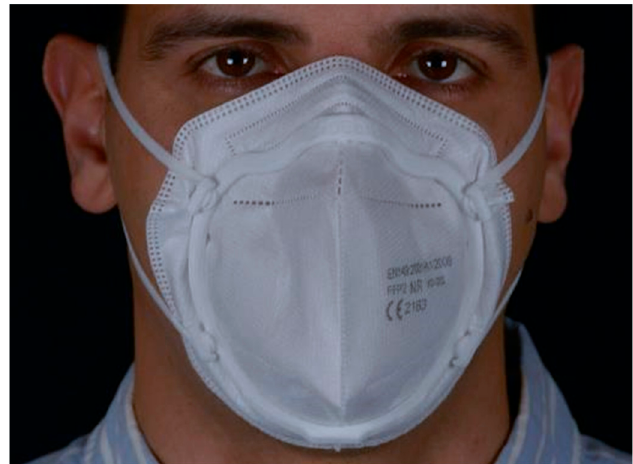
Figure 6. The Mask Fitter positioning.